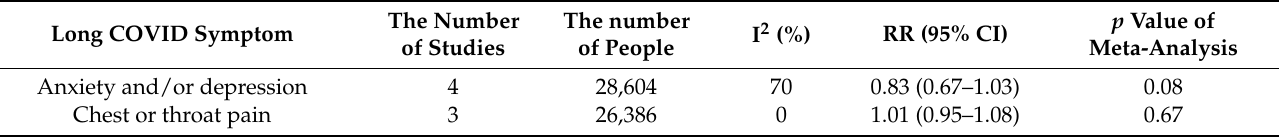
Table 3. Effects of vaccination on long COVID